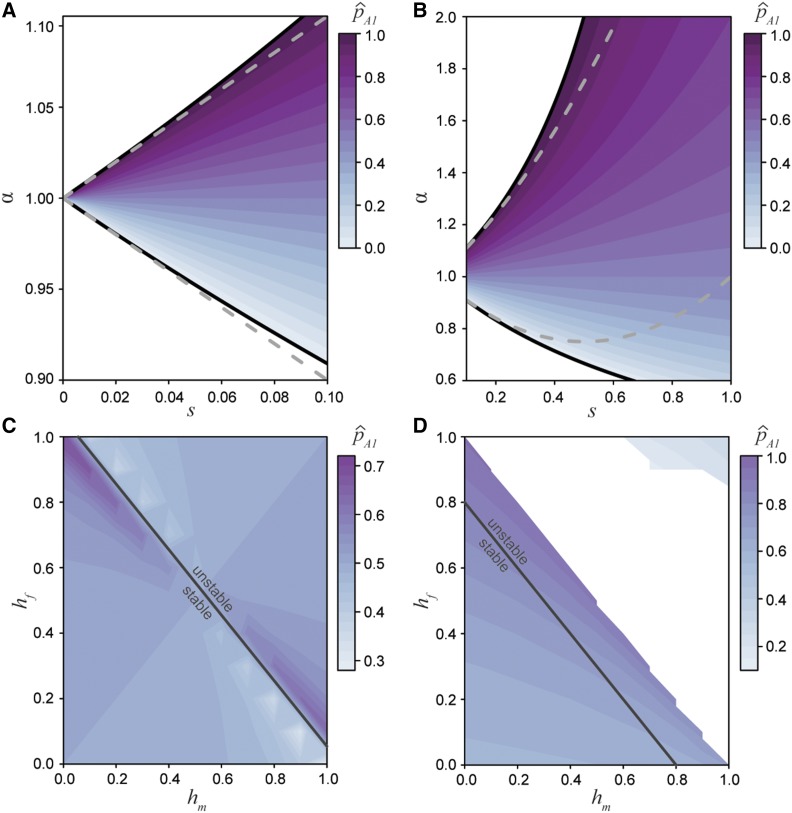
The equilibrium space for the A1 allele under differing selection and dominance conditions. A) The equilibrium space at an additive locus (p^A1, Equation 10), when selection is weak and related between the sexes by the ratio α. Here the equilibrium space is symmetric around α=1 and confined to approximately equal selection between the sexes. The solid black line represent the permissible bounds on α (7) and the dashed gray line represents the first order Taylor series approximation. B) The equilibrium space at an additive locus increases as the strength of selection increases. The solid black line represents the bounds on α and the dashed gray line represents the second order Taylor series approximation. C) The equilibrium space across all dominance conditions when selection is equal between the sexes (s=0.1,α=1). When the dominance coefficients between the sexes sum to no greater than one (hm+hf≤1), then the equilibrium is stable. However, when the sum is greater than one the equilibrium is unstable. D) Strong, asymmetric selection (s=0.4,α=1.5) narrows the equilibrium space and range of stable conditions (hm+hf≤0.8).